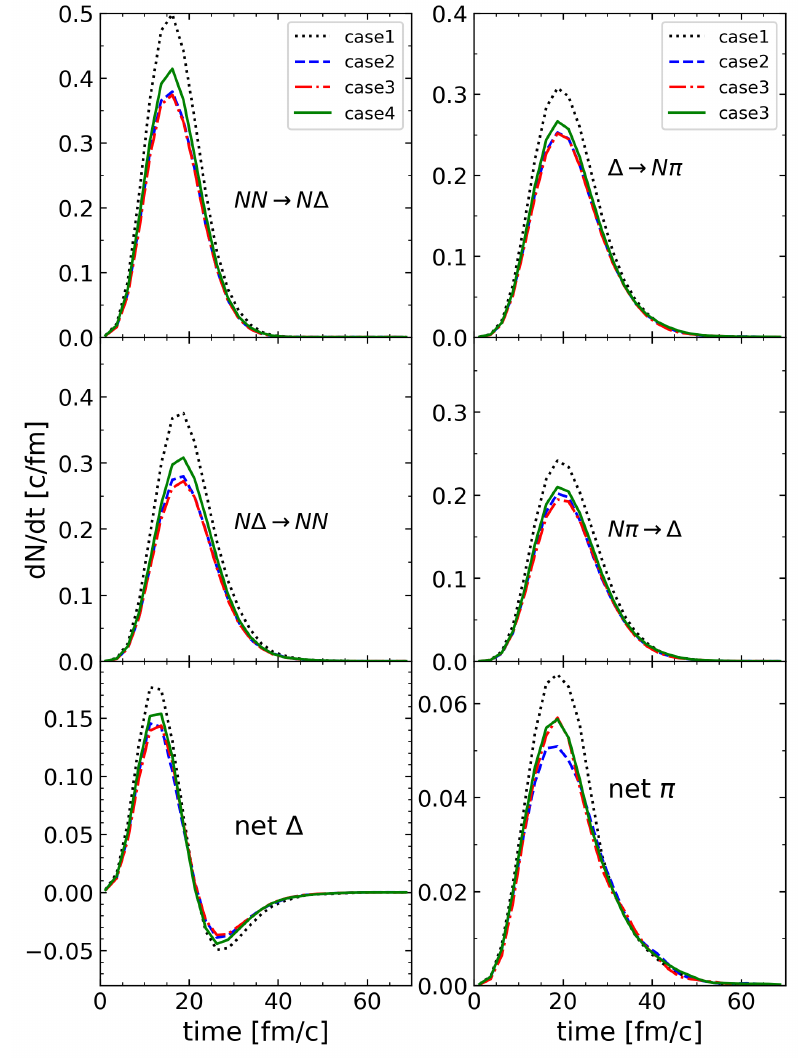
Figure 3. Production and absorption rate for ∆ and pion as a function of time in the neutron-rich system with N / Z = 1.56 ( 132 Sn+ 124 Sn). Net ∆ = dN/dt( NN → N ∆ ) − dN/dt( N ∆ → NN ) and